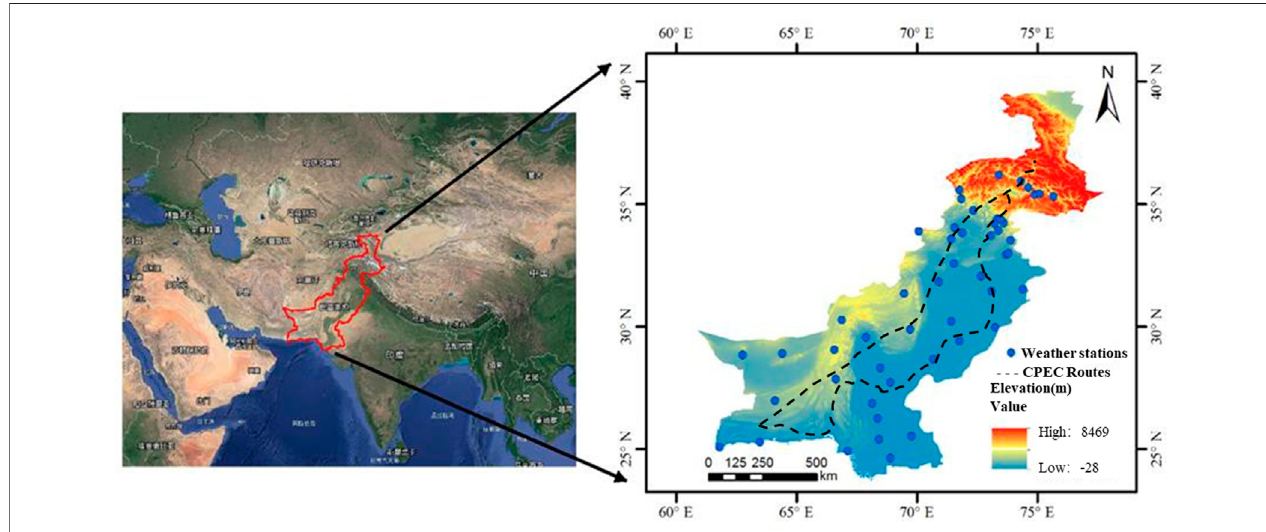
FIGURE 1 | Geographical location and meteorological station distribution of